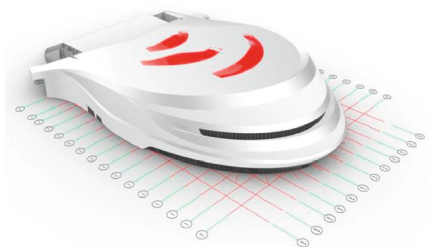
Figure 7: Schematic diagram of the optimization model.